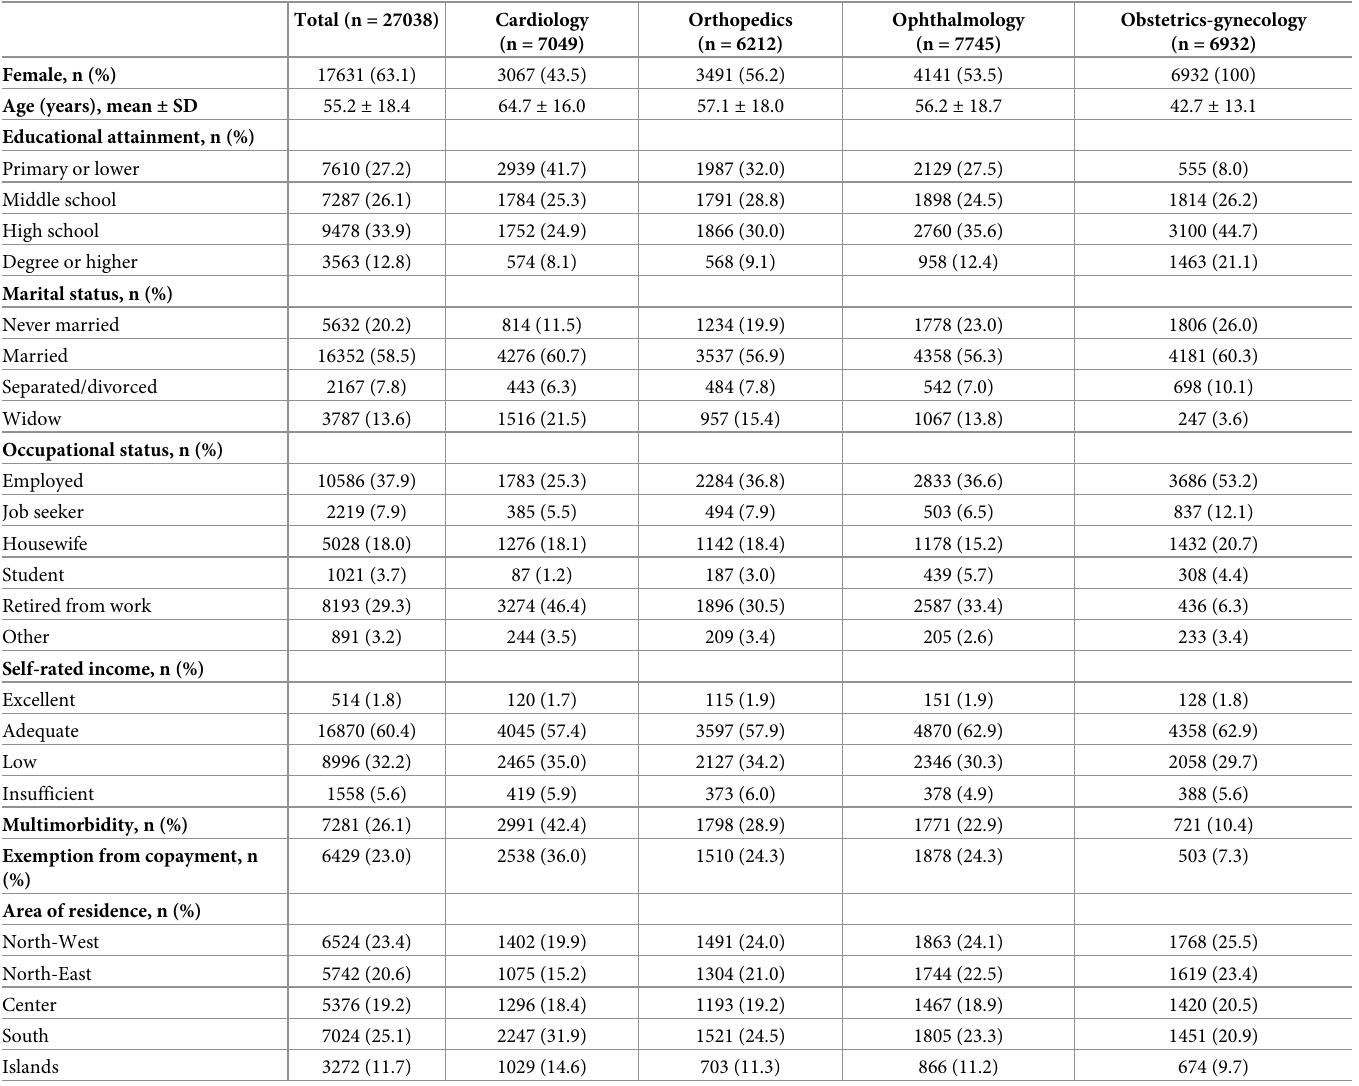
Table 1. Patients characteristics, overall and by medical specialty of the